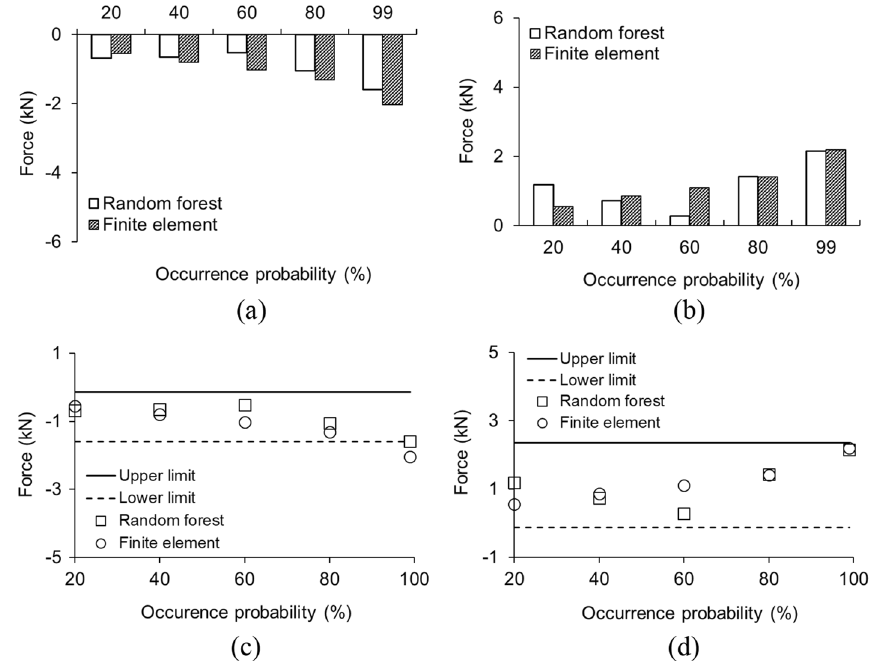
Fig. 10 Comparison of simulated forces: a F t1 ; b F t2 ; c limits for F t1 ; d limits for F